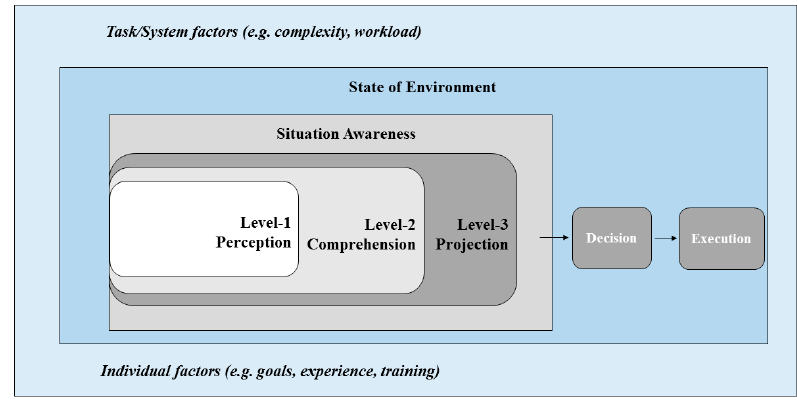
Figure 2. Endsley’s model of SA (reproduced with permission from [36], copyright Øvergård et. al., 2015).